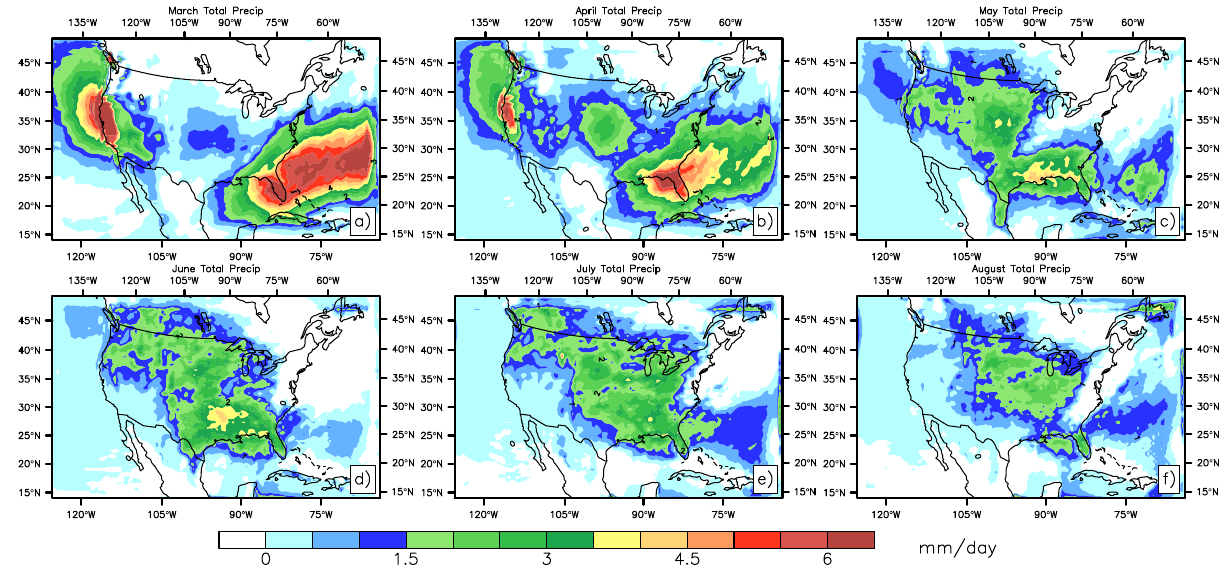
Fig. 9. RegCM3 precipitation anomalies decomposed into single months (mmday − 1 ) for boreal spring and and boreal summer for NINO minus MODERN. Plots are (a) March, (b) April, (c) May, (d) June, (e) July, and (g)